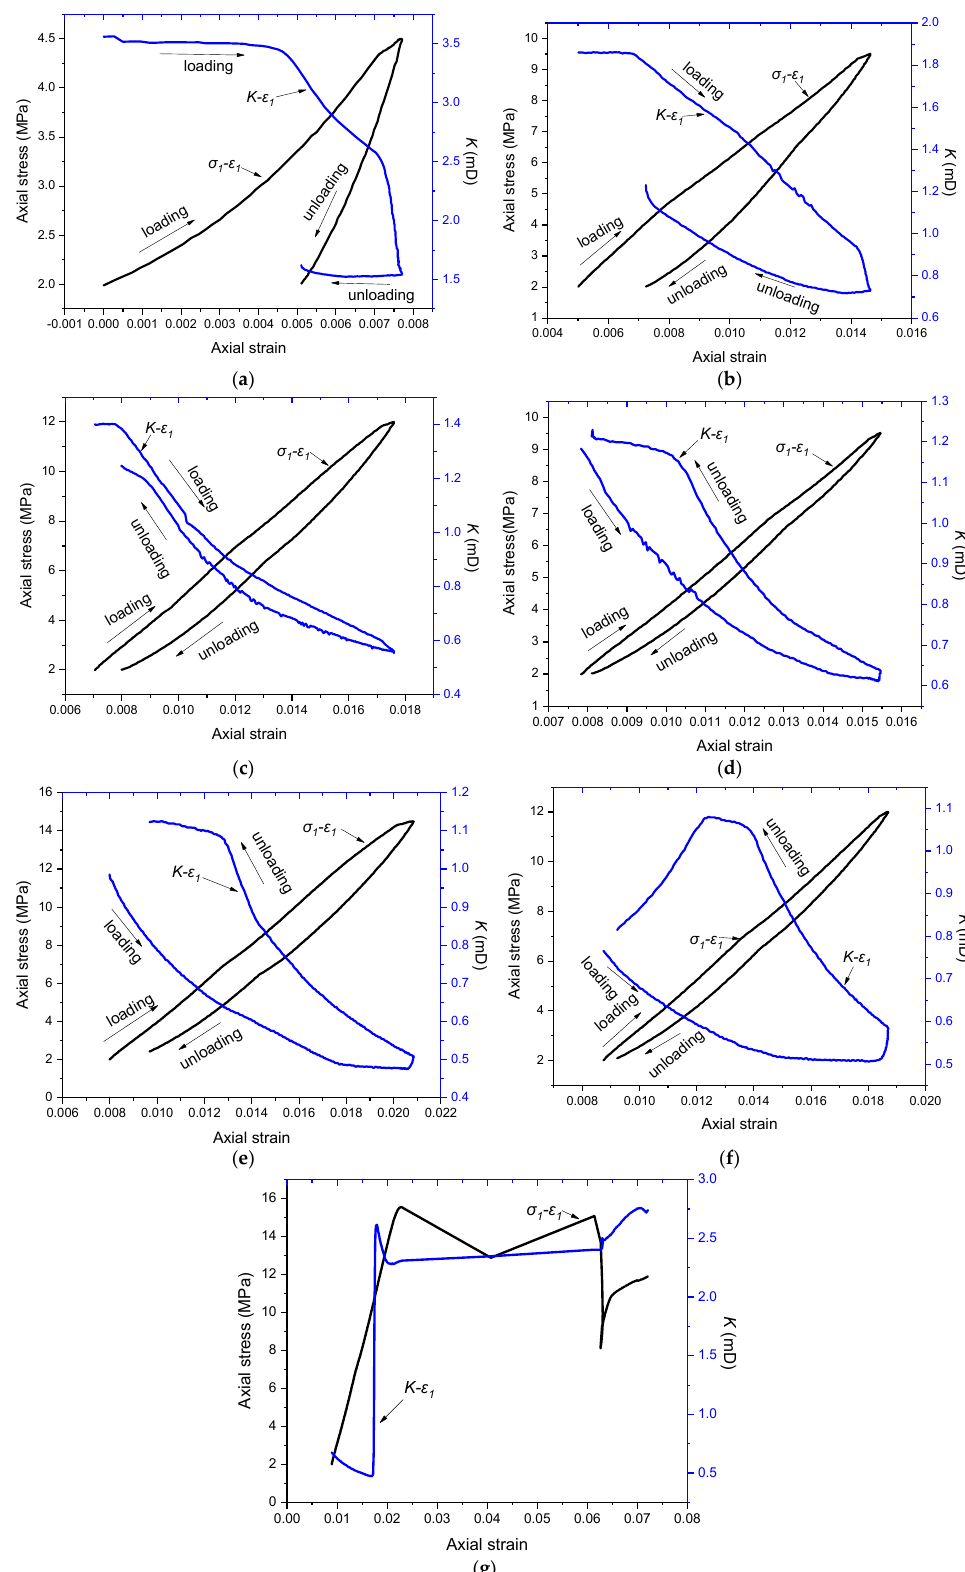
Figure 11. The axial stress–axial strain and permeability–axial strain curves of raw coal during each cycle under stress path 3. ( a ) The first cycle. ( b ) The second cycle. ( c ) The third cycle. ( d ) The fourth cycle. ( e ) The fifth cycle. ( f ) The sixth cycle. ( g ) The seventh